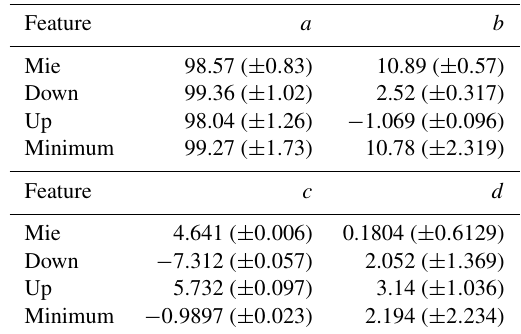
Table A2. Fit parameters of the sigmoid fit for the discrimination probabilities P i